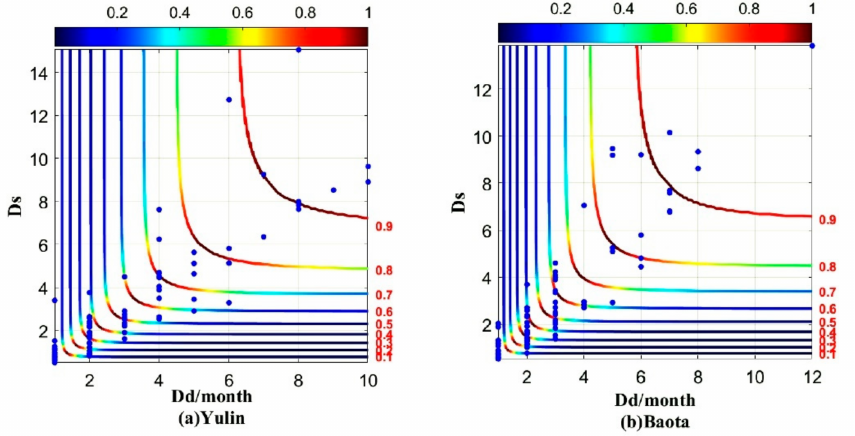
Figure 5. The joint probability Yulin ( a ) and Baota ( b ) drought variables from 1960 to 2019.